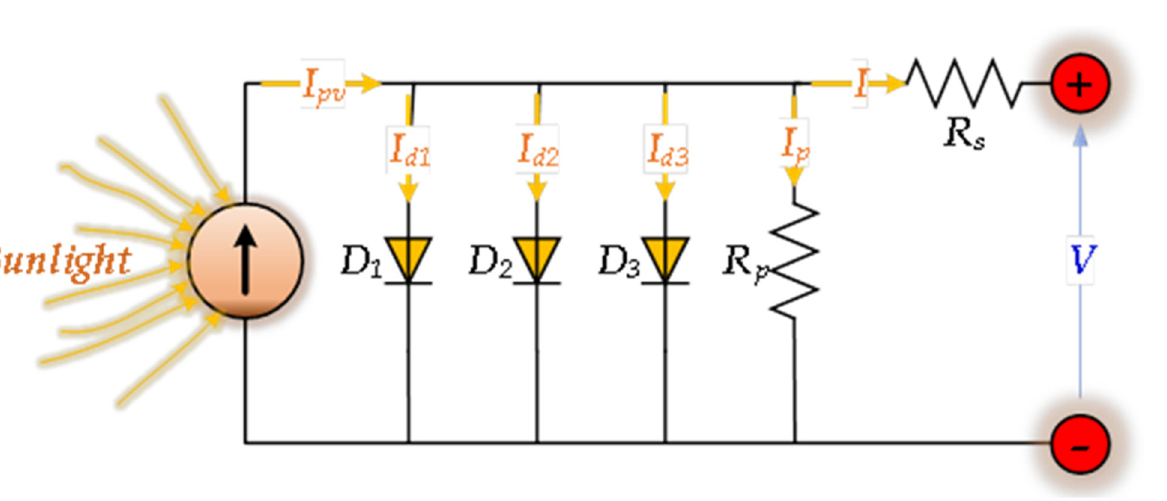
Figure 1. Current density–voltage curves of control and modified PSCs with device structure (inset).